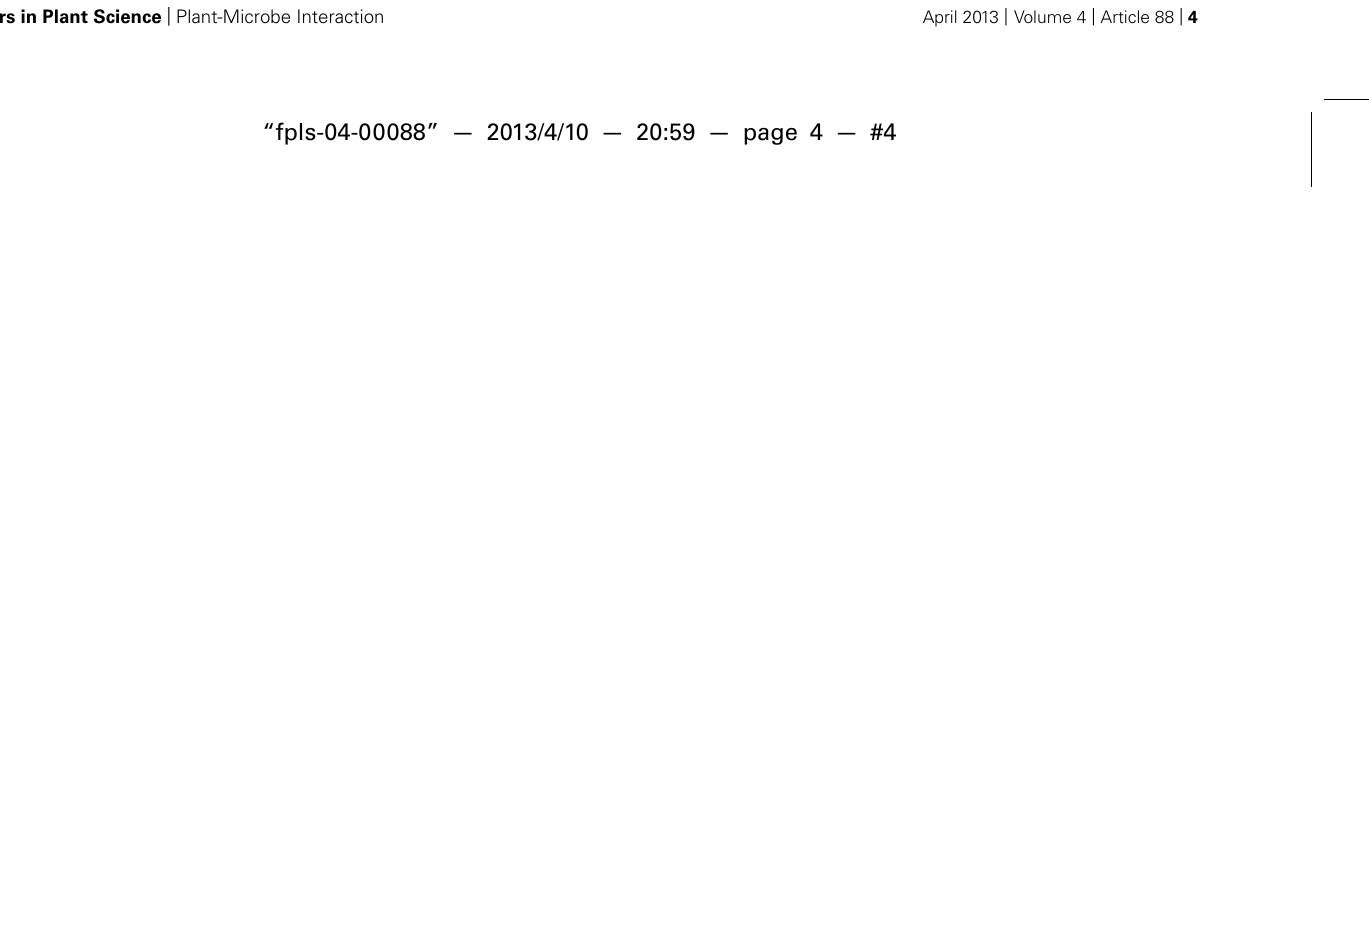
cDNAs were loaded.The amplification of Actin1 mRNA serves as an internal standard for different RNA samples used in the amplification reactions. (B) Expression of a NIMIN3 Pro ::GUS reporter gene in transgenic tobacco seedlings. Expression from the NIMIN3 promoter is compared to reporter gene expression from the NIMIN1 , NIMIN2 , and Nt PR-1a promoters. Tobacco seedlings (T1 generation) transformed with the indicated reporter genes were grown on MS medium with kanamycin or on selective medium supplemented with 0.3 mM SA.Two independent lines for each construct or, as in case of the Nt PR-1a promoter, two different constructs were analyzed. Seedlings were stained for GUS reporter enzyme activity when